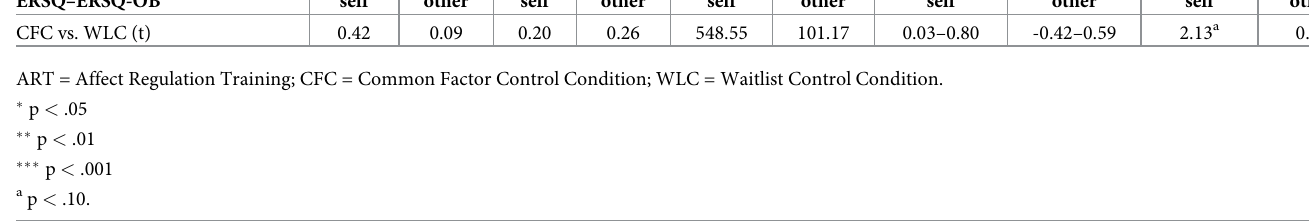
PLOS ONE | https://doi.org/10.1371/journal.pone.0220436 August 29,